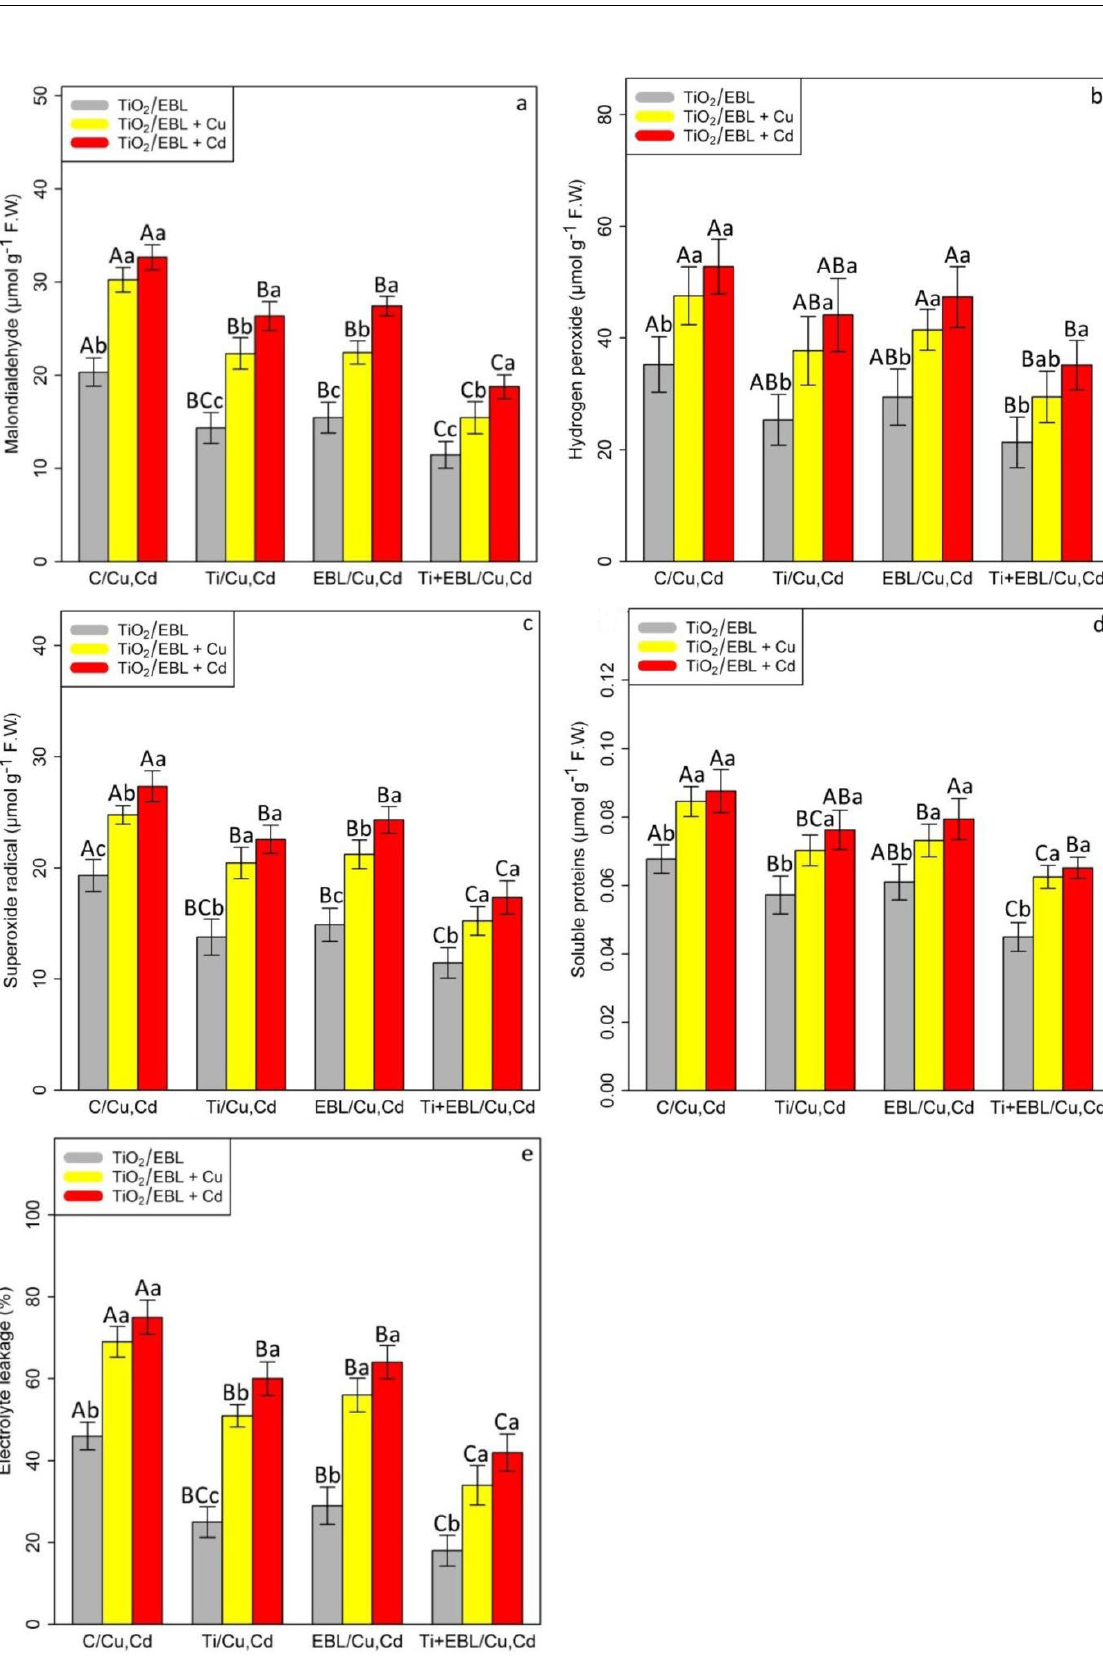
Figure 2. The impact of the co-application of 24-epibrassinolide and titanium oxide nanoparticles individually and combined on malondialdehyde content (MDA) ( a ), hydrogen peroxide (H 2 O 2 ) ( b ), superoxide radical (O 2 •− ) ( c ), soluble proteins (SP) ( d ), and electrolyte leakage (EL) ( e ) in bamboo species ( Pleioblastus pygmaeus ) with 100 µM Cu and 100 µM Cd. In this study, 1-year-old branches